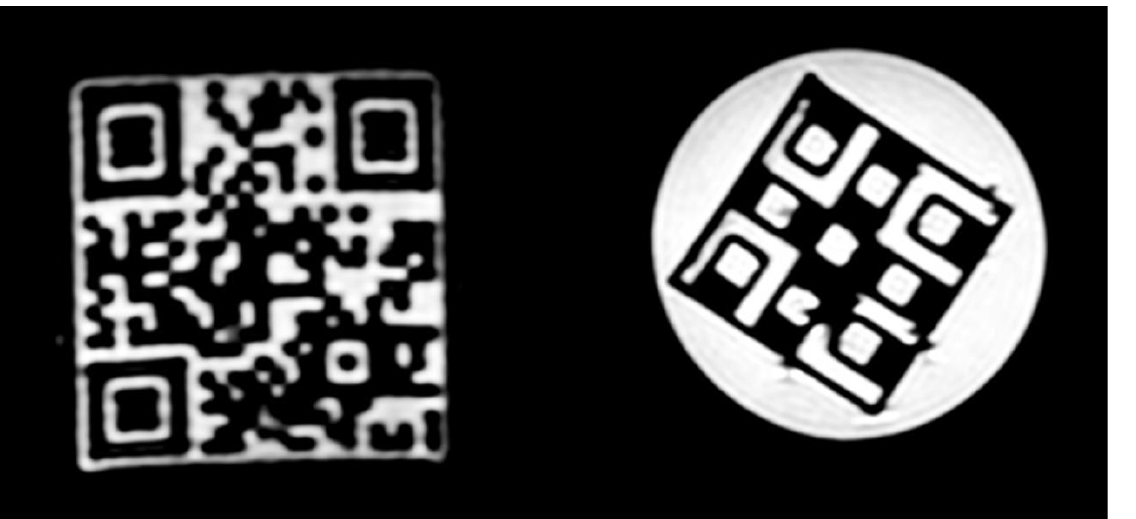
Figure 3. Representative coronal MR images of 3D printed phantoms. The left is the large QR cube, and the right is the Hilbert cube. The interested readers can read the presented QR code MR image using their smartphone’s QR code reader.